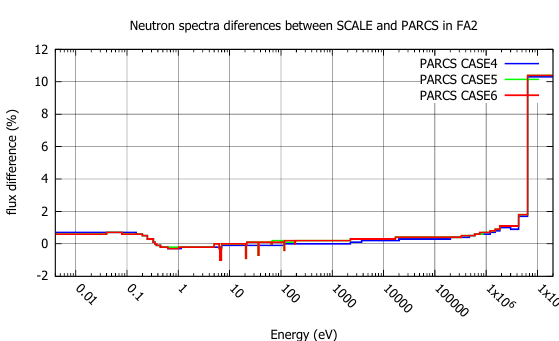
Figure 12. Relative difference in spectra between SCALE and PARCS calculation for FA2 for 0.7% fuel